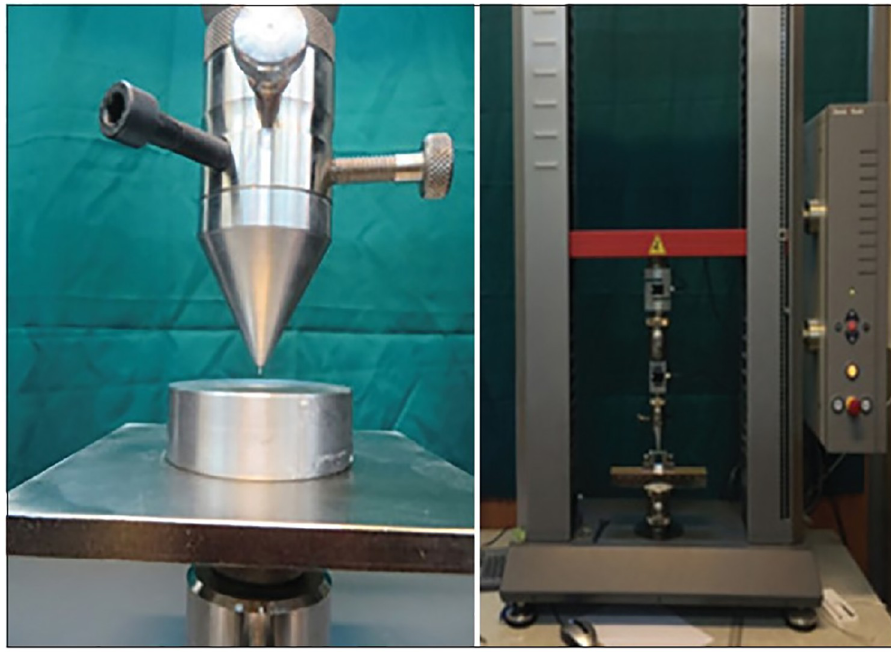
Fig 2. Universal testing machine.